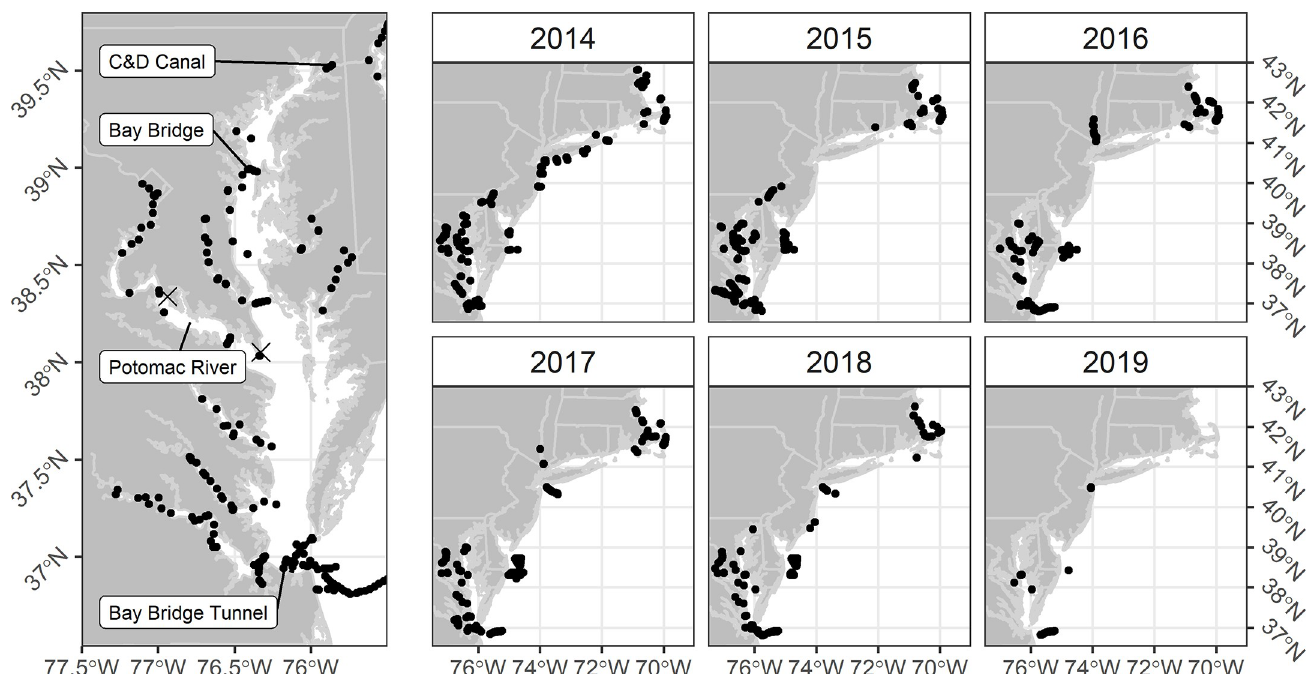
Fig 1. Telemetry receivers deployed in Mid-Atlantic and southern New England estuarine and shelf regions. Receivers shown as filled circles, where Potomac River striped bass have been detected. Locations of tagging locations shown by X symbols. Note disappearance of NY Bight receivers 2015–2016 and increased DelMarVa shelf receiver arrays in